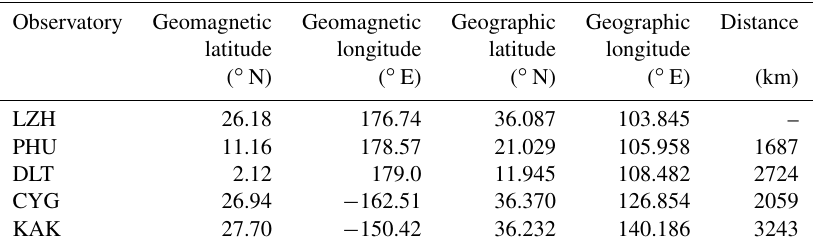
Table 1. Locations of geomagnetic observatories. Geomagnetic coordinates from IGRF model for year 2014 (Thebault et al., 2015), geo- graphical coordinates and distance between Lanzhou and the other observatories.